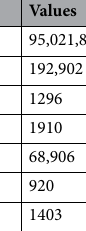
Table 2. Summary of A. konjac buds transcriptome